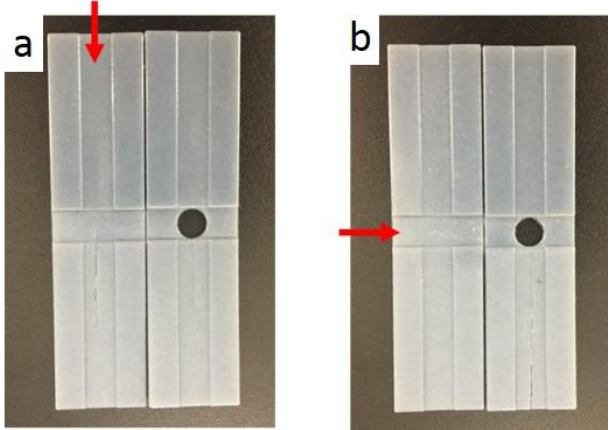
Figure 18. Fracture for the 0.5 mm sample. ( a ) After repeating method 1; ( b ) After repeating method 2.